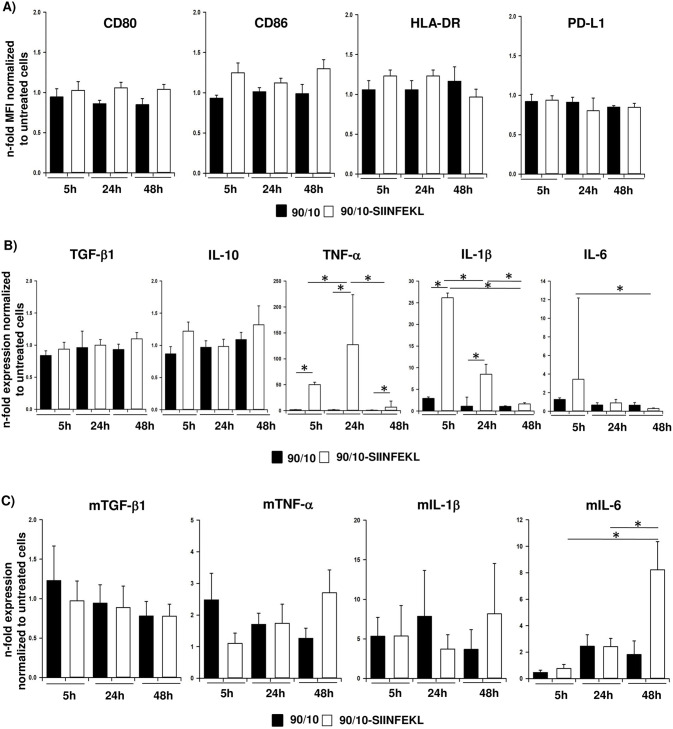
Uptake of CNPs promotes a pro-inflammatory phenotype of DCs.Human and murine DCs (DC2.4) were either left untreated or incubated with 100 μg/ml empty (90/10) or SIINFEKL-loaded 90/10-CNPs for 5, 24 and 48 hours. A) Flow cytometric analysis of CD80, CD86, HLA-DR and PD-L1 cell surface levels in human DCs. Median fluorescence intensity (MFI) ratio was calculated by normalizing MFI of each surface marker to the MFI of its respective isotype control. Then, MFI ratio of CNP treated cells was normalized to untreated cells and expressed as n-fold MFI of untreated cells. B+C) Relative mRNA levels of TGF-β1, IL-10, IL-1β, IL-6 and TNF-α in B) primary human DCs and C) murine DC2.4 cells was determined by RT-qPCR. Expression levels were normalized to expression of the housekeeping gene TBP/GAPDH and normalized to values determined for untreated cells. Data are presented as mean + SEM or median with 75th and 25th percentile of three independent experiments. *p < 0.05.